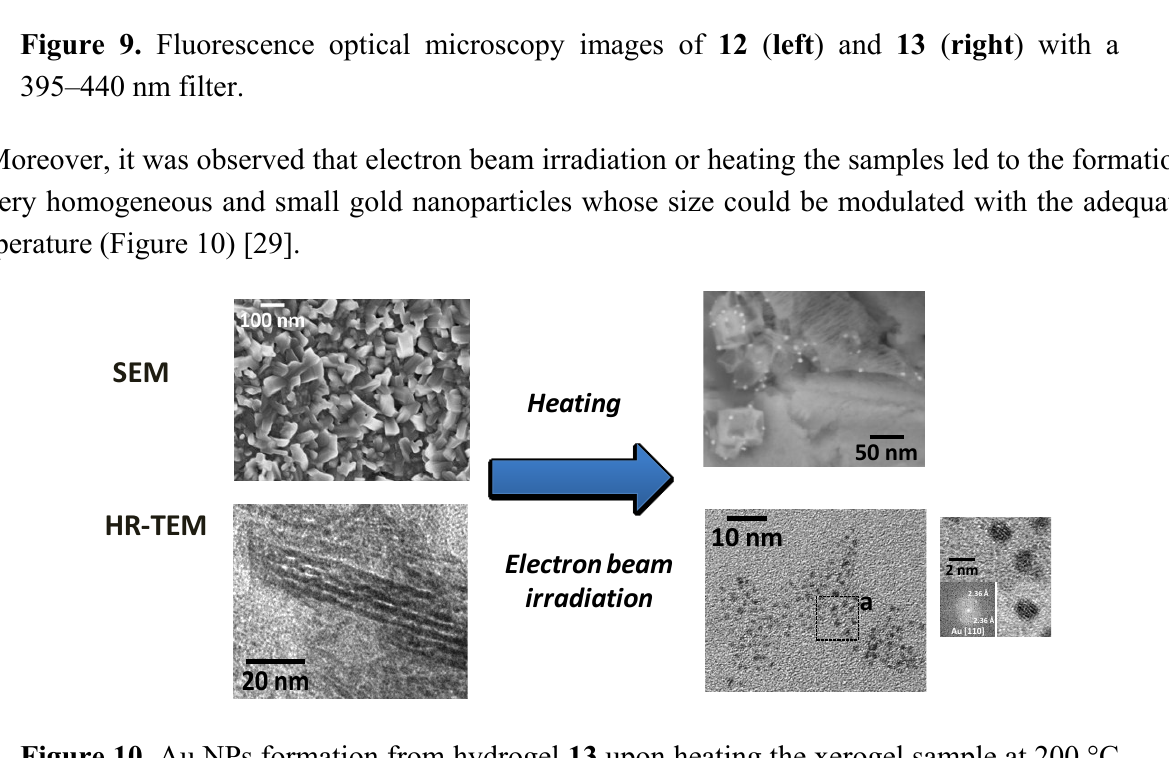
Figure 10. Au NPs formation from hydrogel 13 upon heating the xerogel sample at 200 °C ( above ) or irradiation with electrons ( below